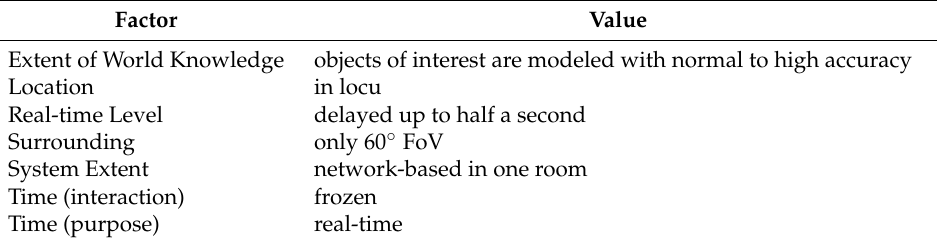
Figure 9. Data flow during “ robot supervision” (adapted from Robinett [4]). Table 10. Space and